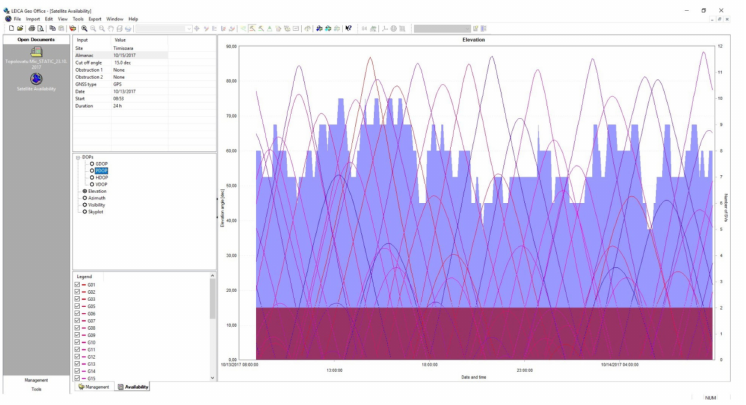
Figure 10. Height of